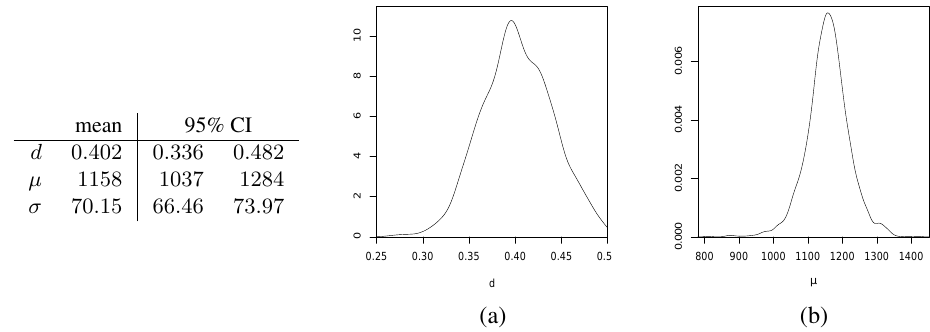
Figure 12. Table: summary posterior statistics for Nile minima. Plots: marginal posterior densities for Nile minima – (a) d , (b) µ .